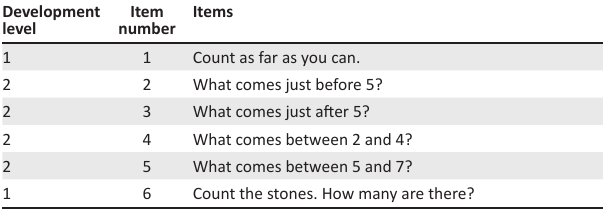
TABLE 3: Mathematical and Arithmetic Competence Diagnostic items according to development levels. Development level